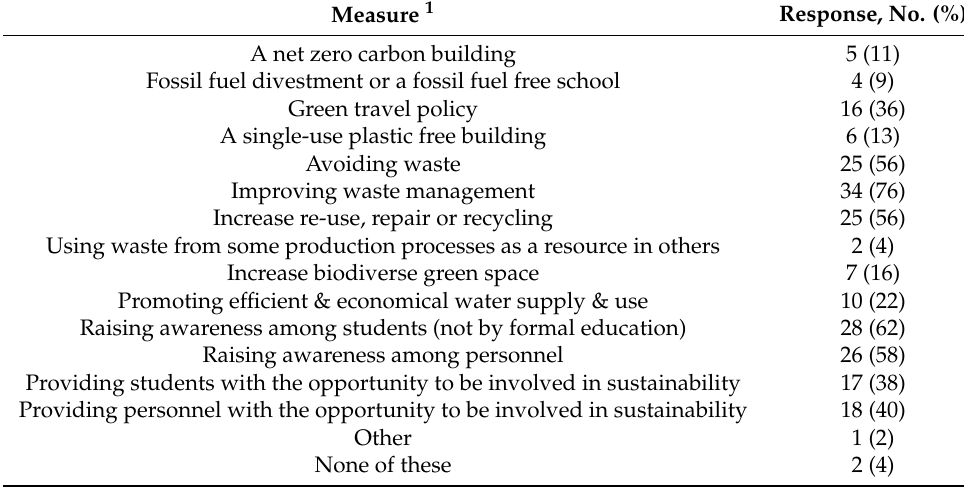
Table 4. Measures taken by schools to reduce its ecological